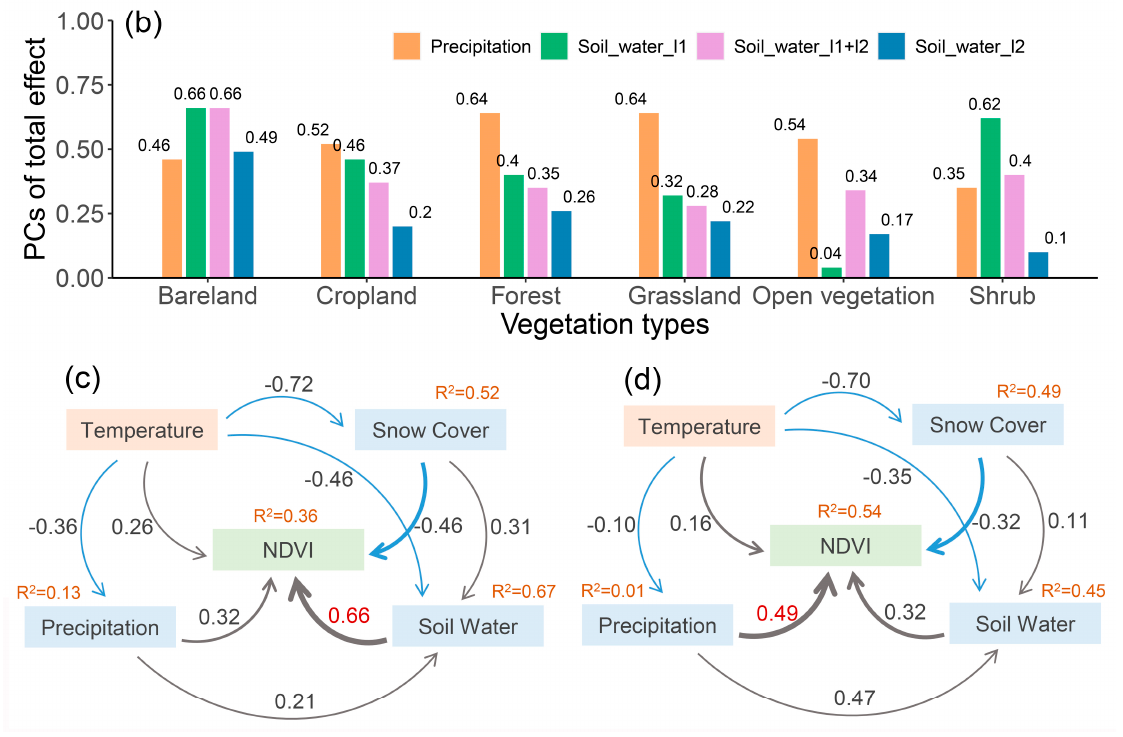
Figure 7. Area of different vegetation types at different elevation gradients: ( a ) total effects of precipitation, the first layer of soil water, the second layer of soil water, and the total of the two layers of soil water on vegetation. ( b ) The “soil_water_l1” is the first layer of soil water, “soil_water_l2” is the second layer of soil water, and “soil_water_l1+l2” is the sum of the two layers. SEM results for bare land ( c ) and grassland ( d ). Gray arrows represent positive correlations, blue arrows represent negative correlations, and thicker arrows represent larger